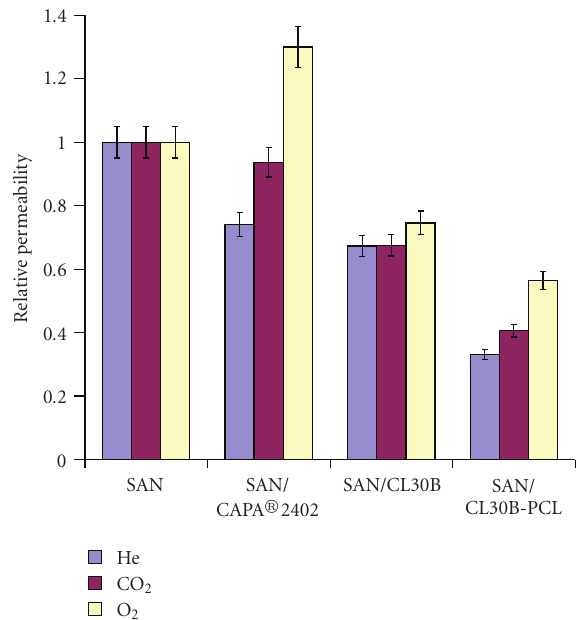
Figure 8: Relative gas permeability of SAN, SAN/CAPA 2402, SAN/CL30B, SAN/CL30B-PCL with 3wt% of